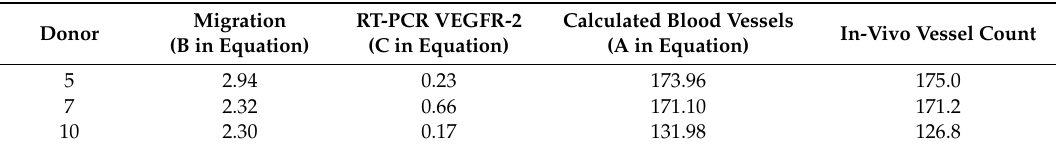
Table 2. Regression analysis calculations for representative donors and actual blood vessels counts in the mice model for the same